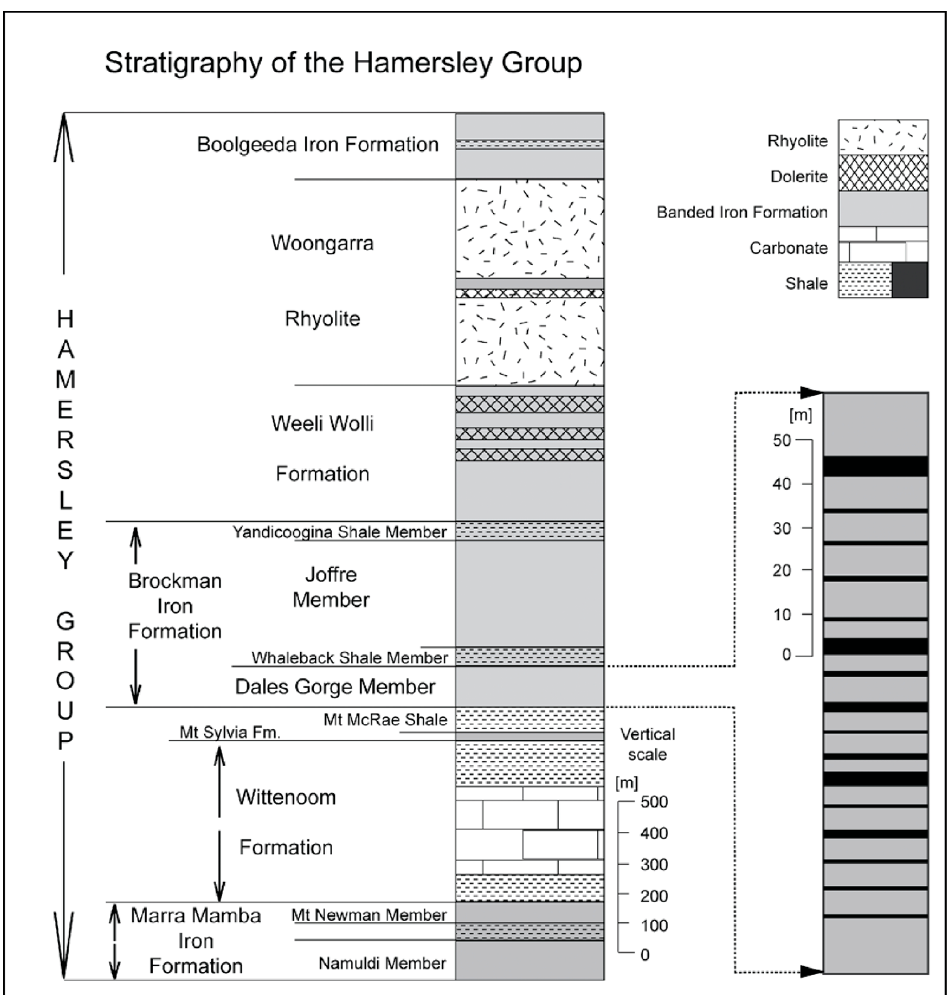
Figure 2. Stratigraphy of the Hamersley Group illustrating the position of the important iron formations in relation to major uneconomic shale, carbonate or volcanic units. Shale interbeds, illustrated for the Dales Gorge member to the right, internally subdivide the iron formations. The 17 BIF macrobands (grey) are separated by the 16 shale bands (black) that are used for stratigraphic correlation (after [17]).